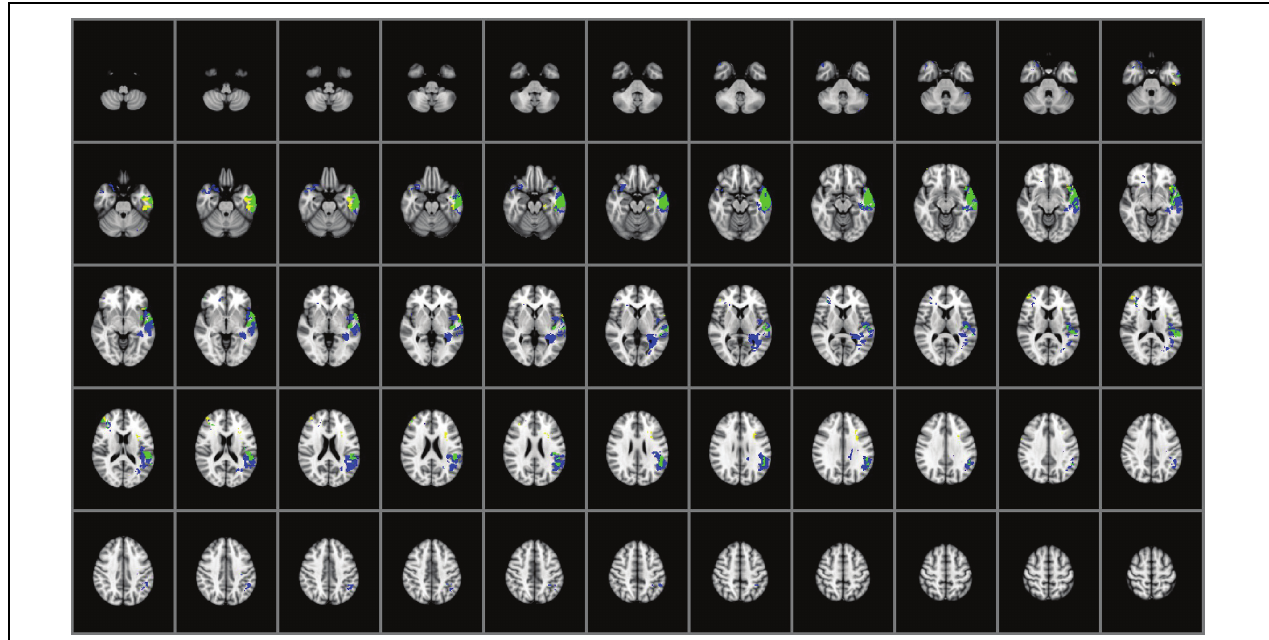
FIGURE 3 | Brain regions common and distinctive to perceiving and managing emotion ( n = 130). Yellow: perceiving. Blue: managing. Green: common to both. In each axial slice, the right hemisphere is on the reader’s left. Jaccard Index = 0.50; η 2 =